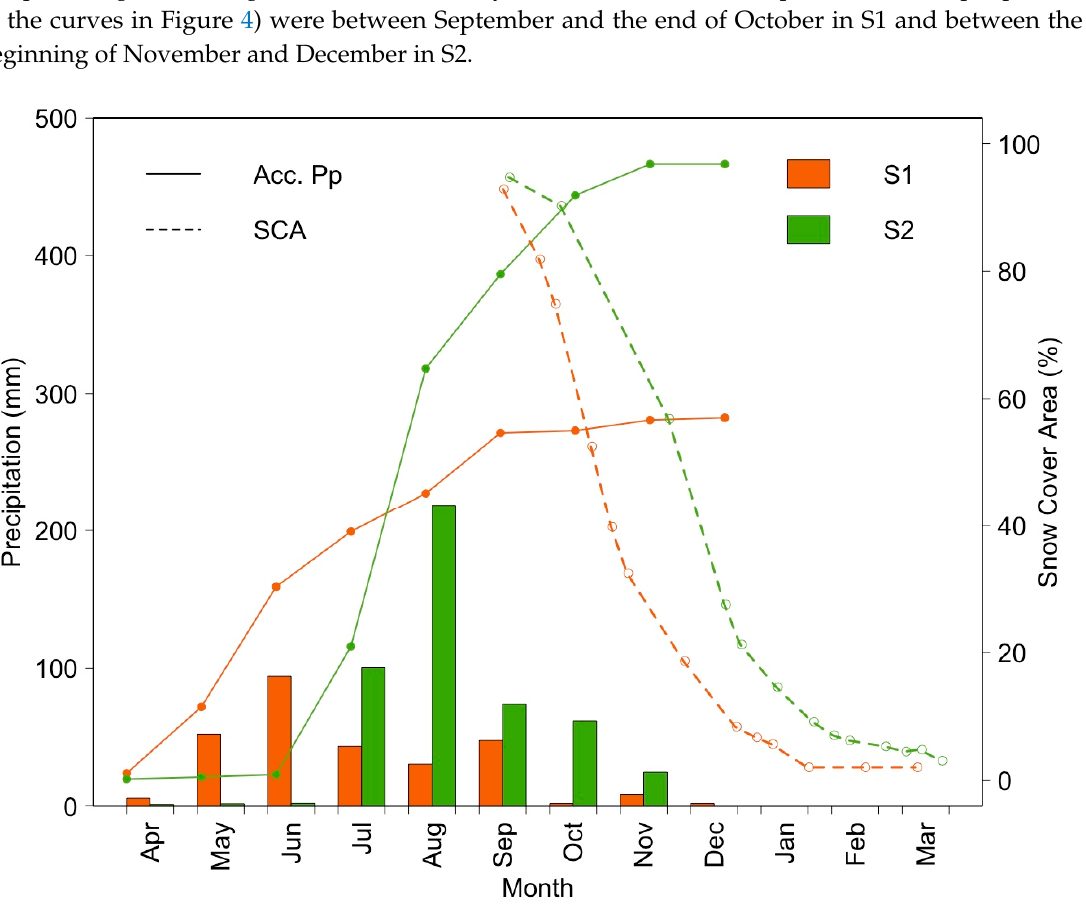
Figure 4. Monthly precipitation (bars), accumulated precipitation (Acc. Pp, continuous line) and percentage of the basin covered by snow (SCA, dotted line) during both ablation seasons in the Estero Morales basin.